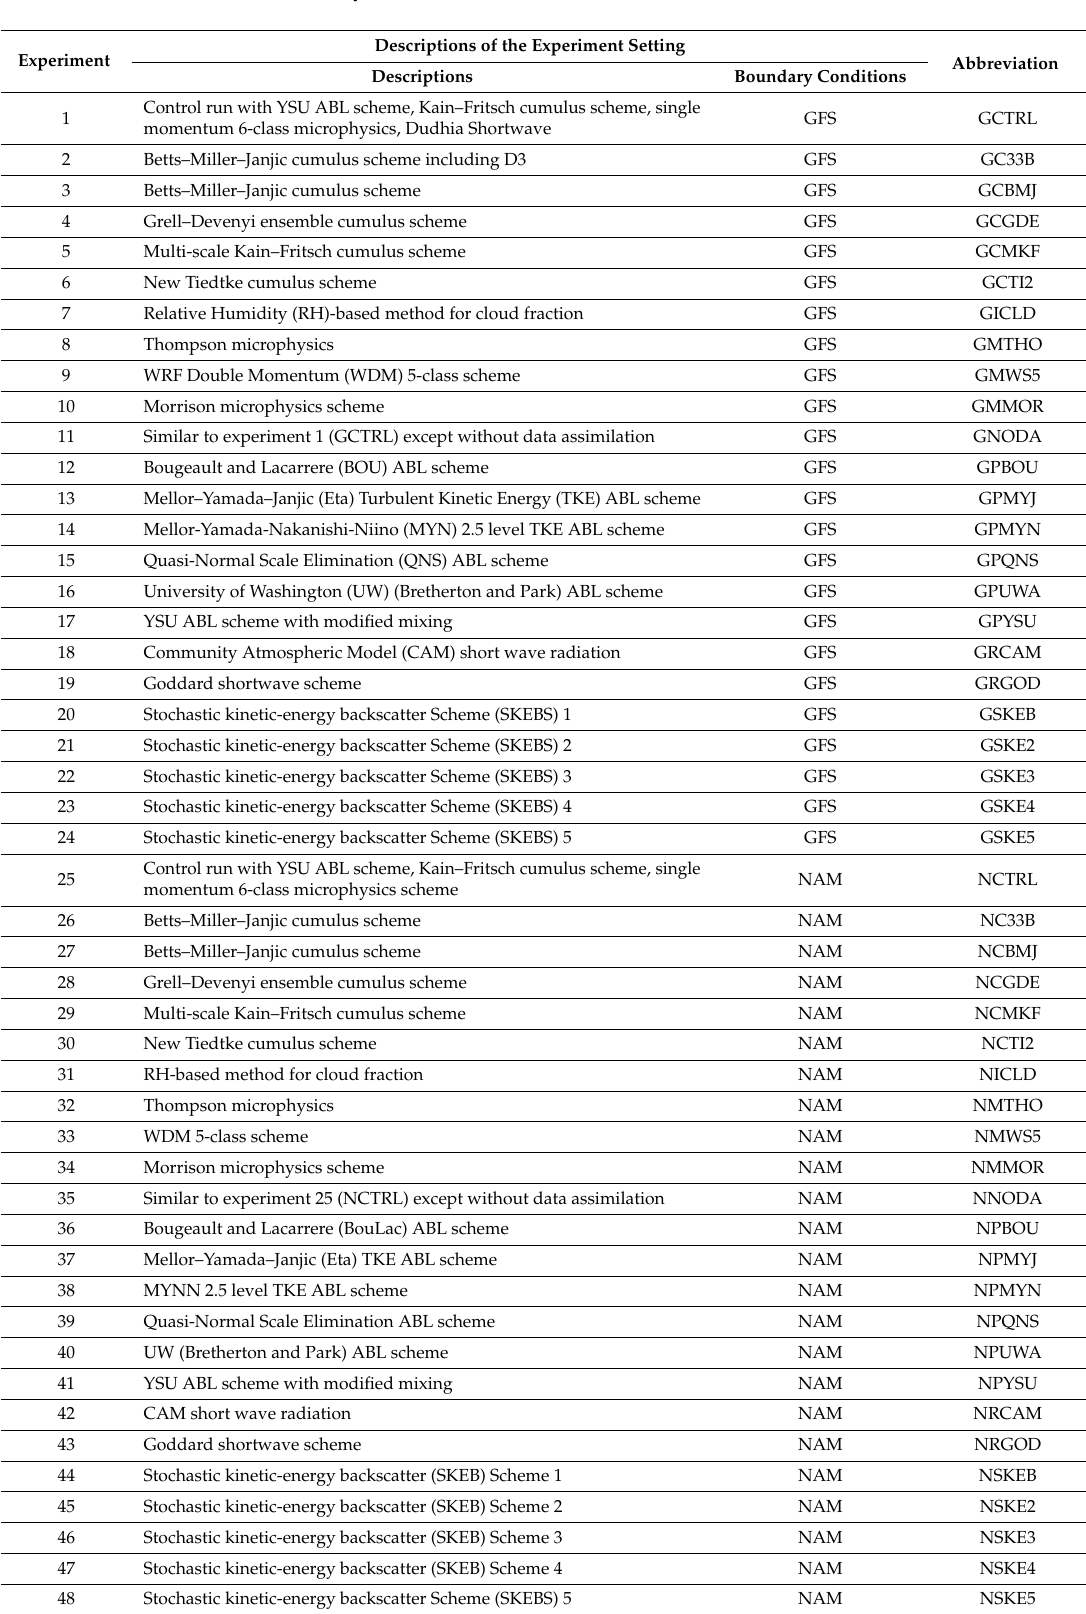
Table 1. List of experiments. YSU: Yonsei University; GFS: Global Forecast System; NAM: North American Mesoscale Forecast